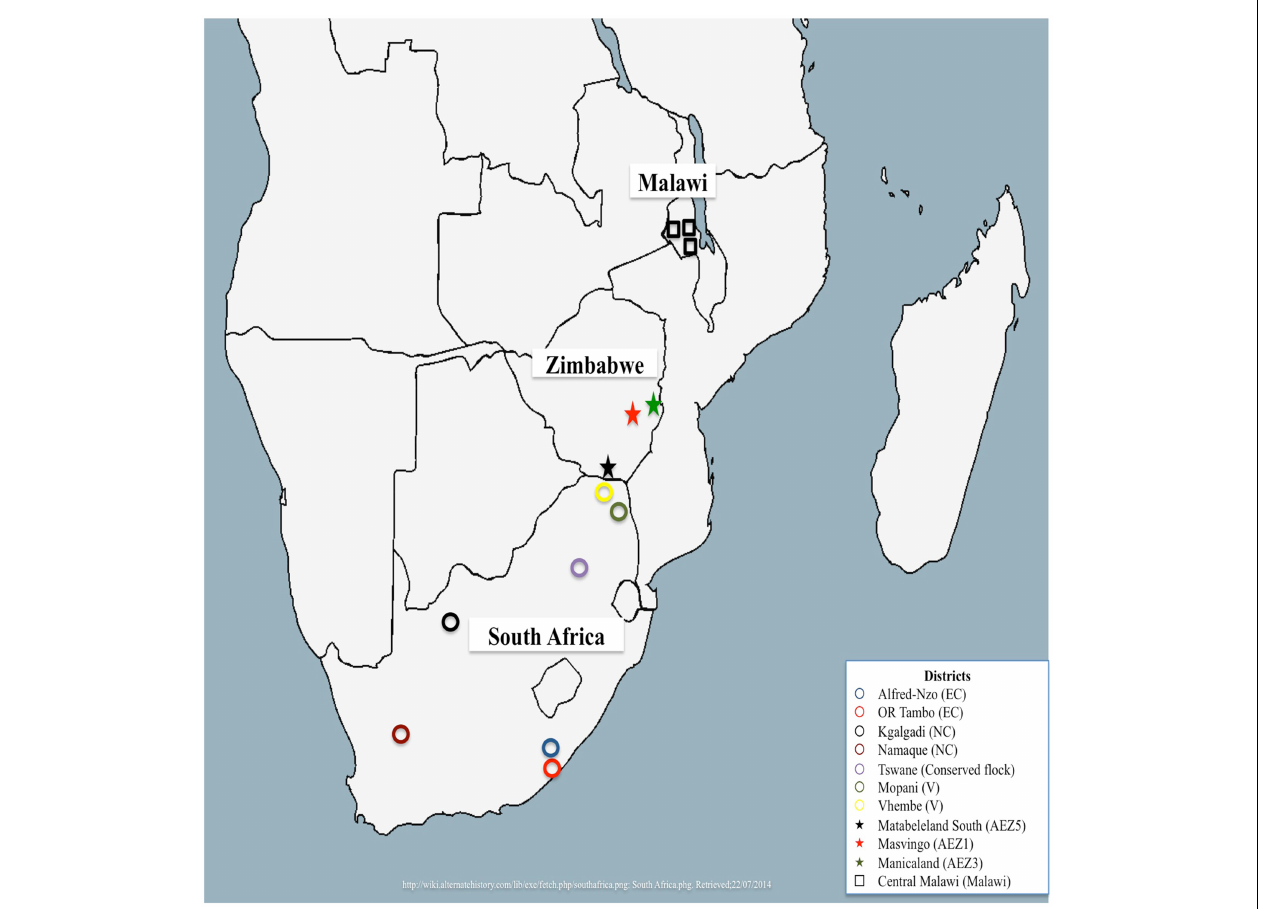
FIGURE 1 | Map showing sampled regions from Malawi, South Africa, and